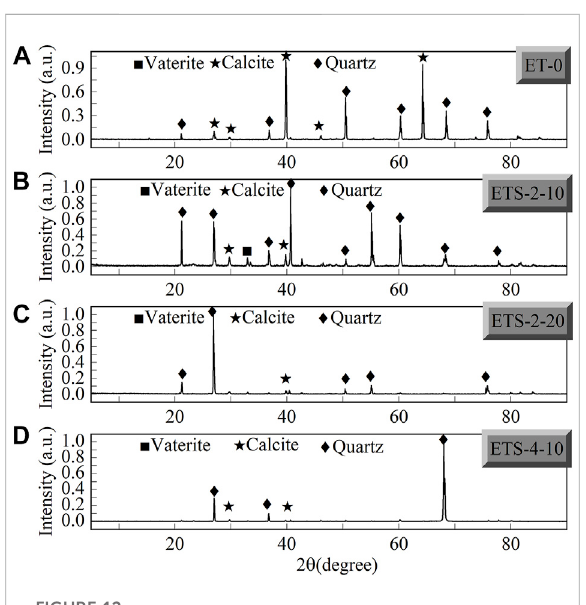
FIGURE 12 XRD test results of the EICP-treated sand: (A) ET-0; (B) ETS- 2-10; (C) ETS-2-20; (D)